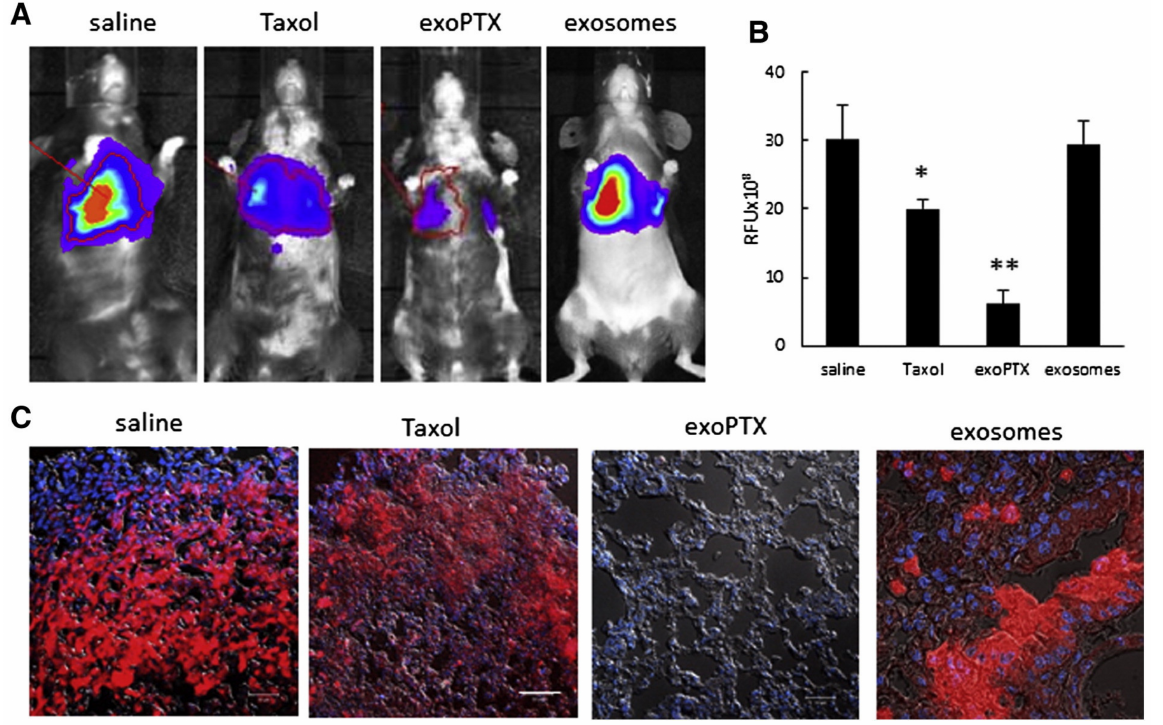
Figure 8. The inhibition of metastases growth in mouse lungs upon exosome-loaded paclitaxel (exoPTX) treatment. C57BL/6 mice were i.v. injected with 8FlmC-FLuc-3LL-M27 (red) cells to establish pulmonary metastases. After 48 h, mice were treated with exoPTX, or Taxol, or saline, or empty sonicated exosomes as a control, and the treatment was repeated every other day, totally, seven times. Representative IVIS images were taken at day 21 ( A ). Statistical significance of metastases levels from IVIS images in lungs of treated animals compared to control mice is shown by asterisk (* p < 0.05; ** p < 0.005) ( B ). At the endpoint, 21 days later, mice were sacrificed, perfused, and lung slides were examined by confocal microscopy ( C ). The bar: 10 µ m. Source: reprinted from Kim, M. S.; Haney, M. J.; Zhao, Y.; Mahajan, V.; Deygen, I.; Klyachko, N. L.; Inskoe, E.; Piroyan, A.; Sokolsky,